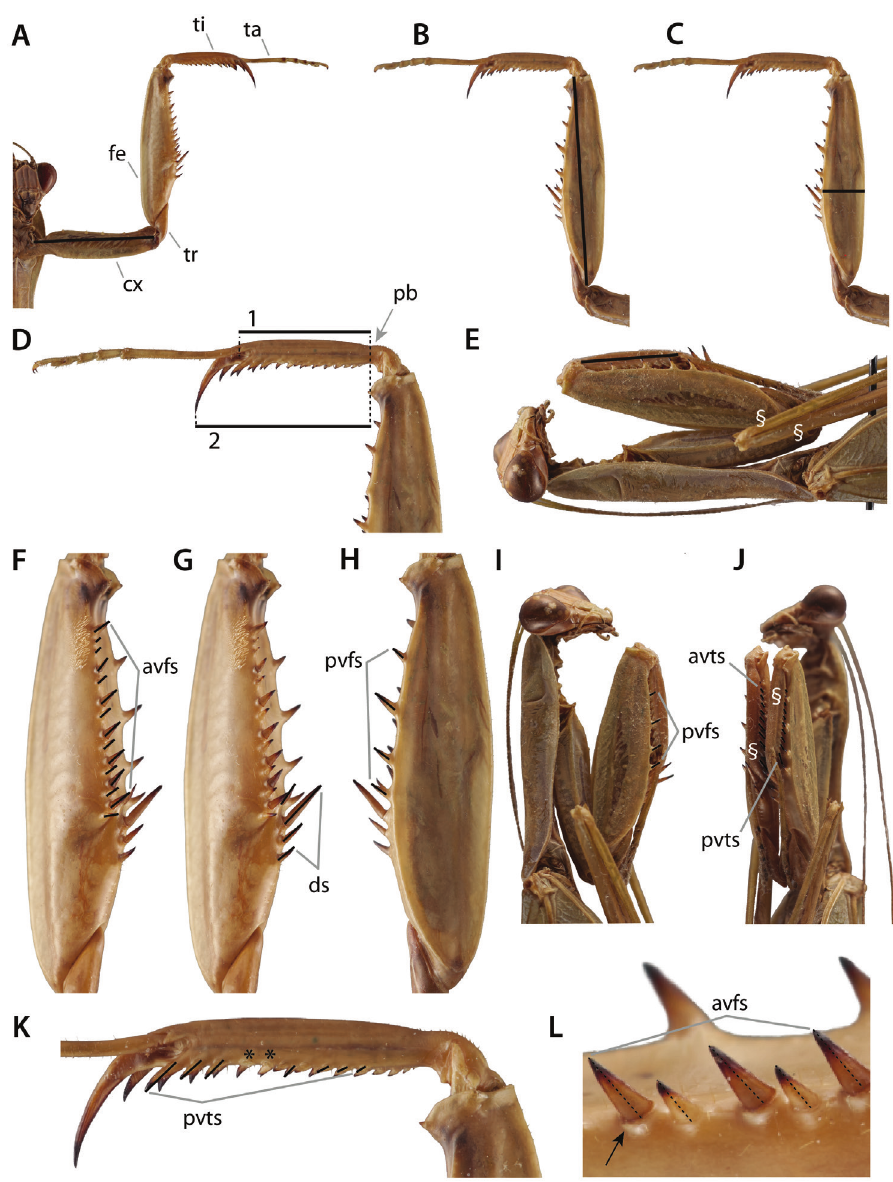
Figure 27. Prothoracic leg and spine measurement standards. Solid black lines indicate approximate location to take length and width measurements. Sphodromantis sp. prepared foreleg measurements ( A – D ): A forecoxal length B forefemoral length C forefemoral width D foretibial length; line 1 measures foretibial length from the proximal bend ( pb ) to the foretarsal insertion site; line 2 accounts for tibial spur length, but does not account for total spur length nor its angle; dashed black lines demonstrate approximate measurement endpoints. Sphodro- mantis sp. E unprepared foretibial length measurement (see note). Sphodromantis specimens presented in F – L are positioned for optimal viewing for the reader, not for obtaining accurate measurements. Ensure that structures are arranged appropriately before obtaining measurements. Prepared forefemoral spine length measurements ( F – H ): F anteroventral femoral spine length G discoidal spine length H posteroventral femoral spine